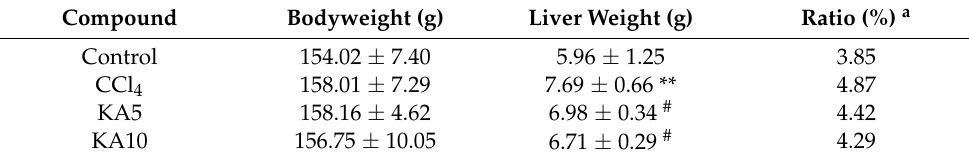
Table 3. Effects of kaempferol on the body and liver weights of rats treated with CCl 4.